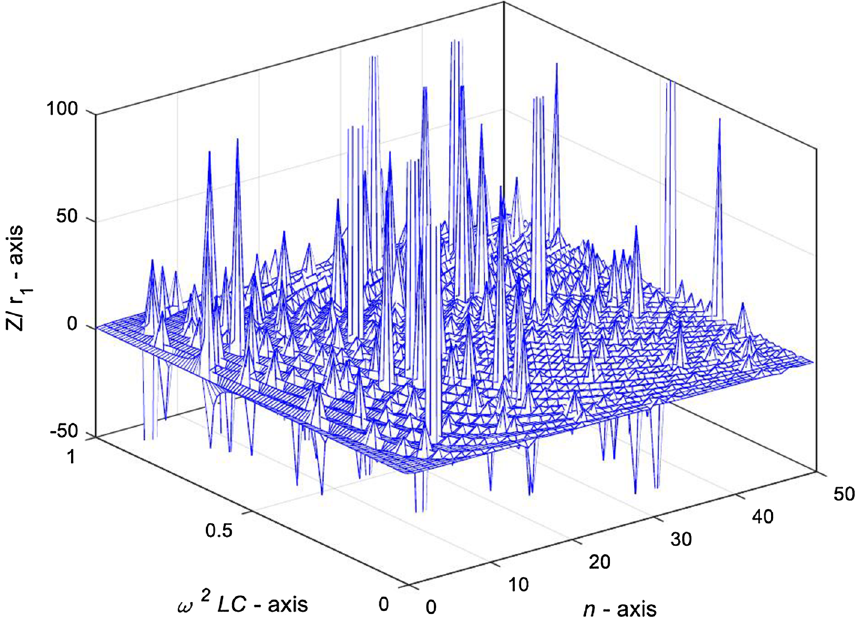
ω 2 LC and n , in case of